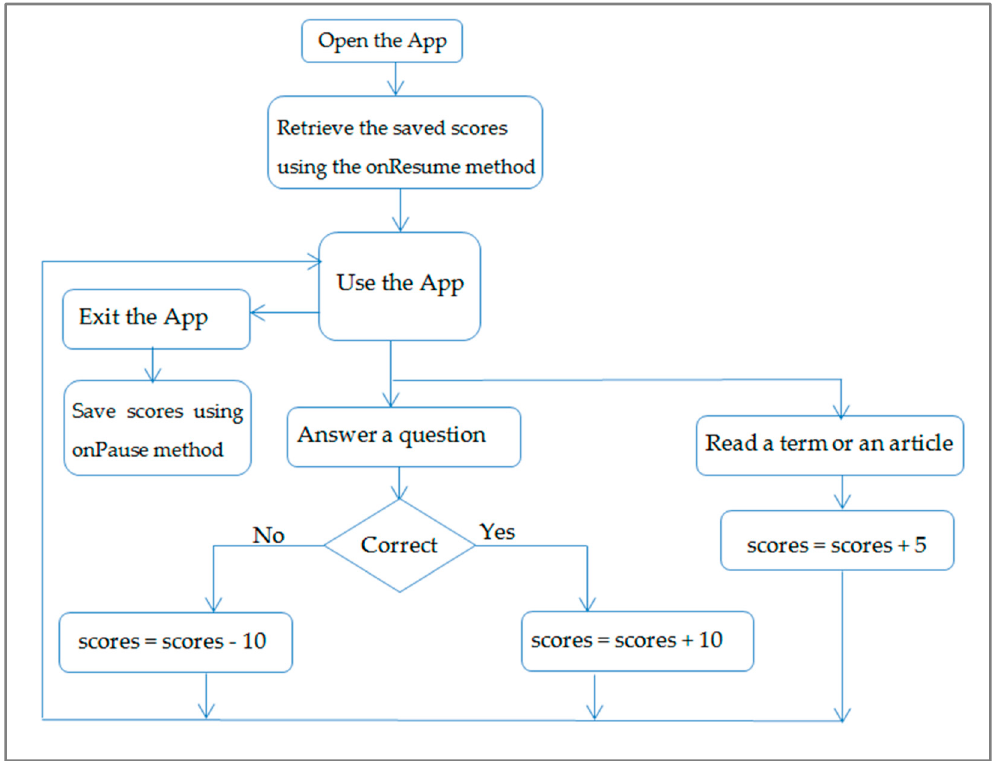
Figure 10. Gamification in “Be Aware of the Hacker” Android App.